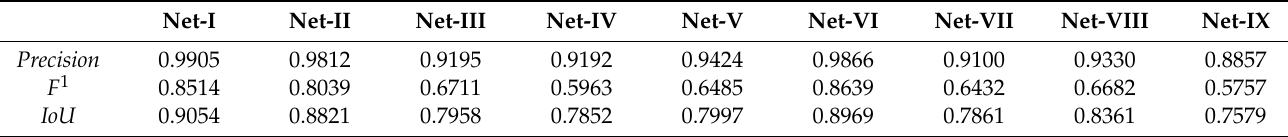
Table 15. Class metrics of cable class of testing images with the C-T ratio of 0.12.